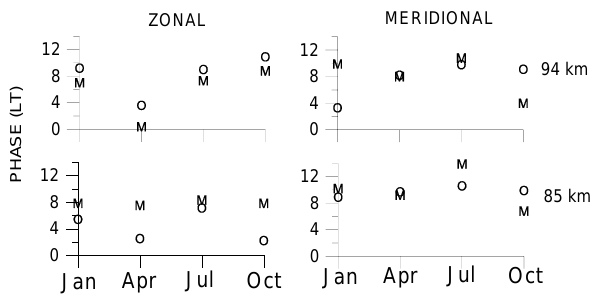
Fig. 12. Same as Figure 8 but for the semidiurnal phase.